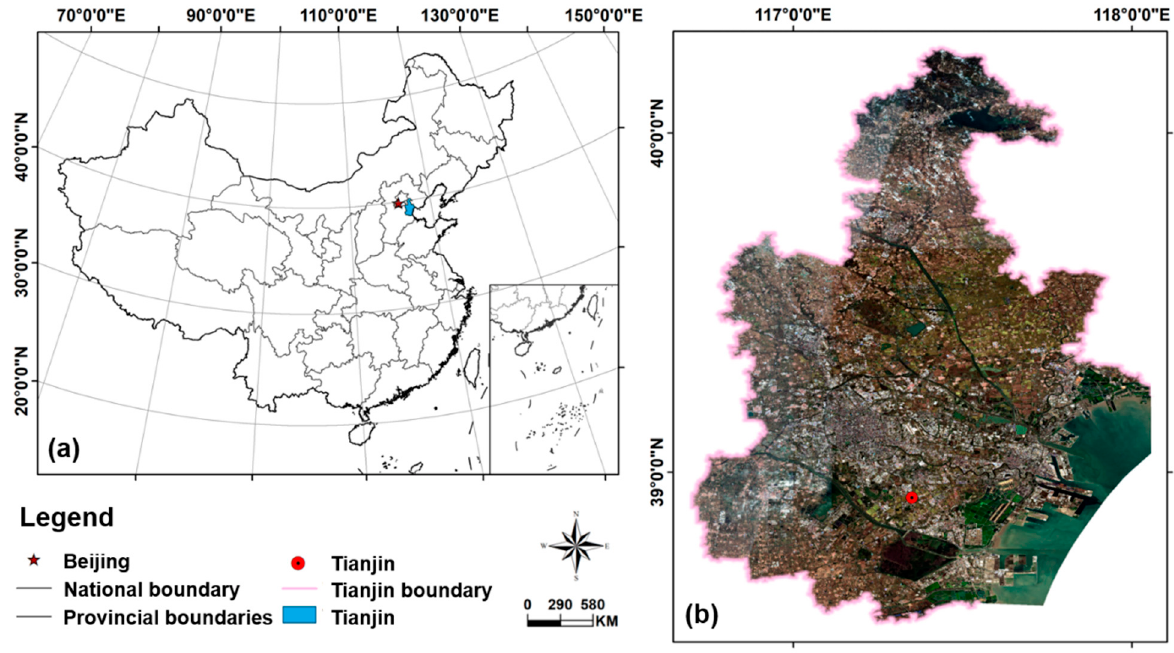
Figure 1. ( a ) Location of the study area in China. ( b ) A true ‐ color image of Tianjin from Sentinel ‐ 2.